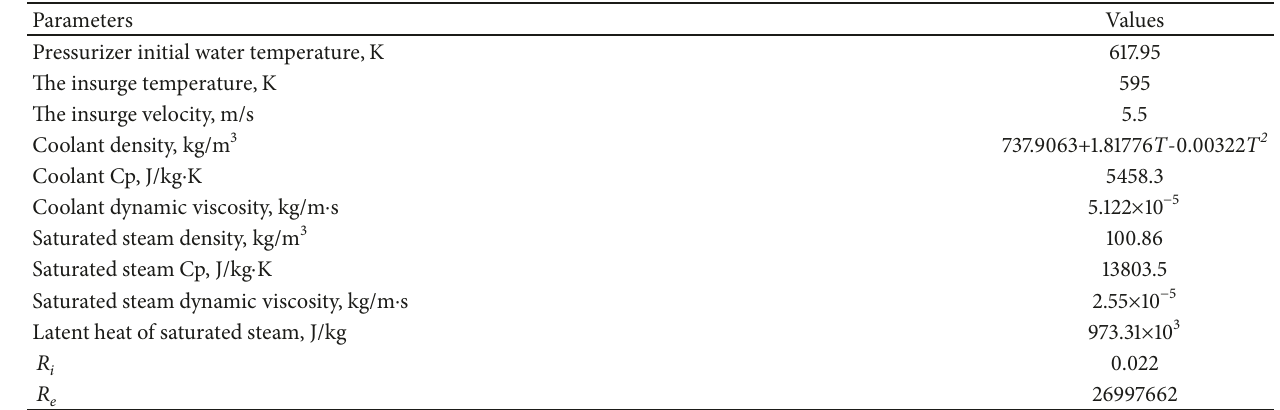
Table 2: Correlative parameters of calculation.